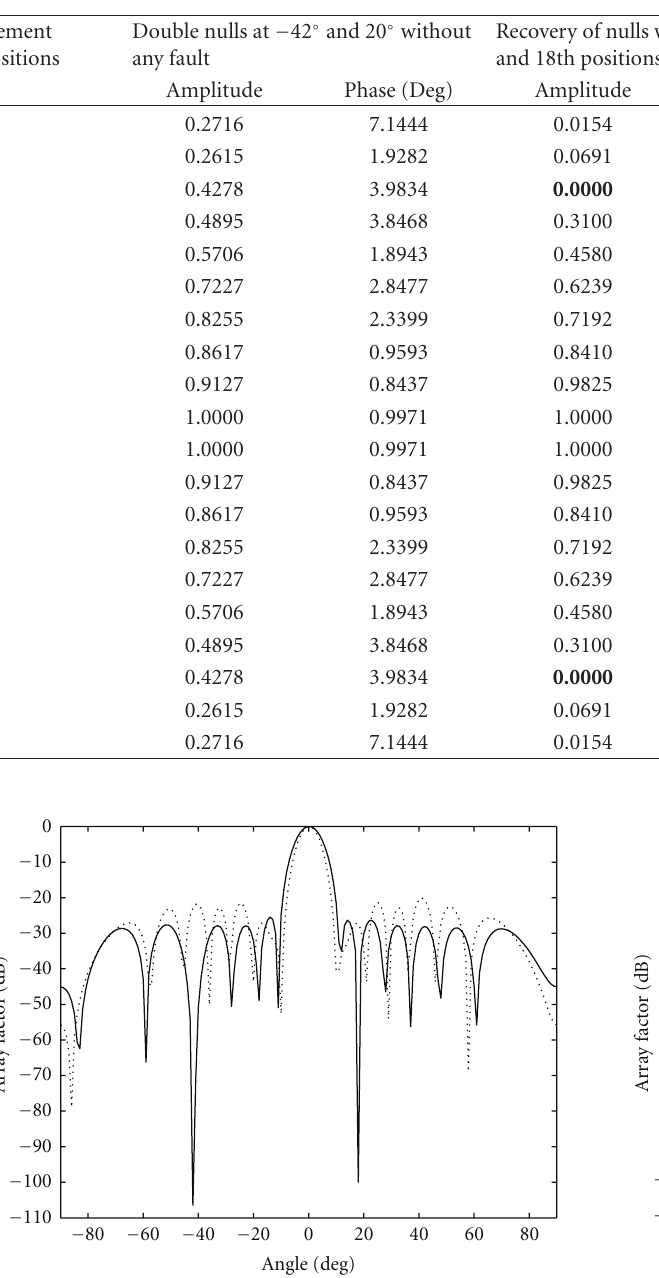
Figure 9: Radiation pattern for 3rd and 18th element failure with main beam at broadside and nulls at − 42 ◦ and 18 ◦ . Dotted line curve shows the damaged array pattern and the solid line curve shows the corrected pattern.